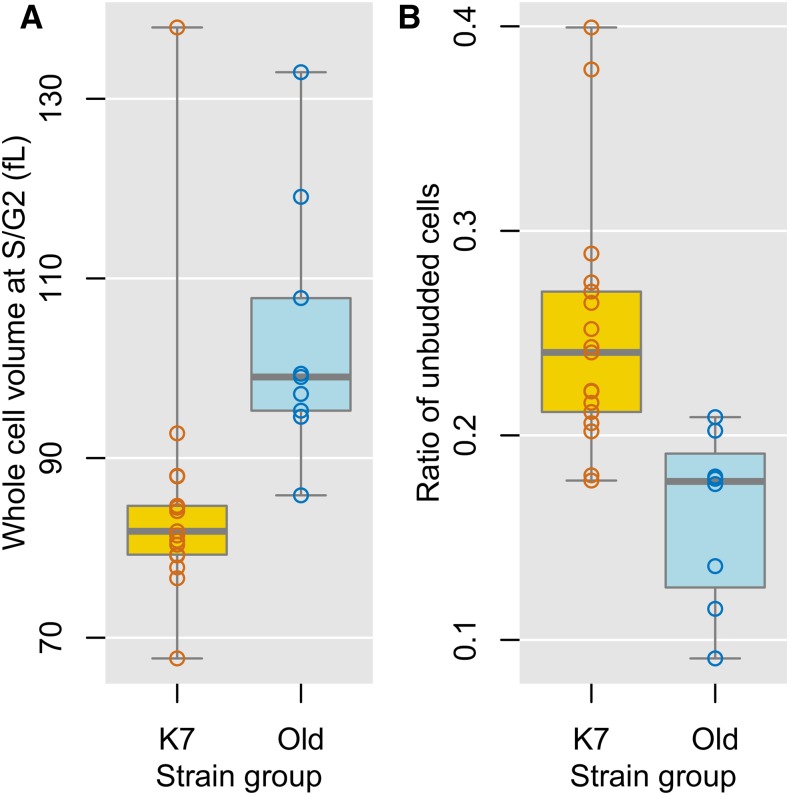
Morphological differences between K7-lineage strain and old sake yeast strains. (A) Whole cell size at S/G2. The whole cell volume at S/G2 is calculated in femtoliter assuming the volume scales like the three-halves power of the area. Circles indicate mean values of each strain (n = 5). (B) Ratio of unbudded cells. All old sake yeast strains except for K2 are plotted. Circles indicate mean values of each strain (n = 5).